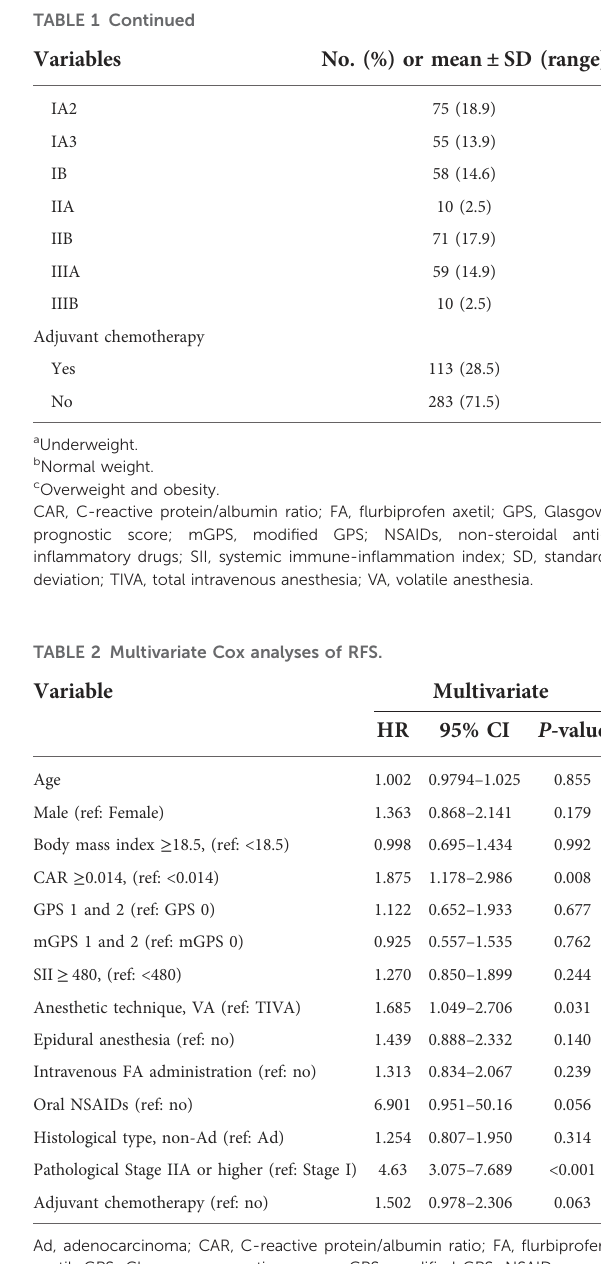
TABLE 1 Patient characteristics.